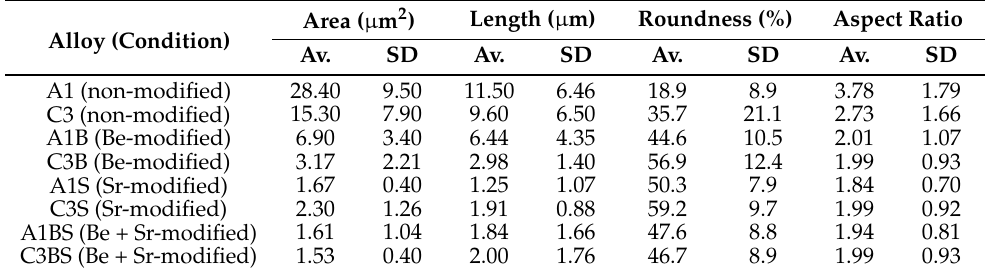
Table 4. Eutectic silicon particle measurements for as-cast 357 alloy samples (DAS ~ 25 µ m).